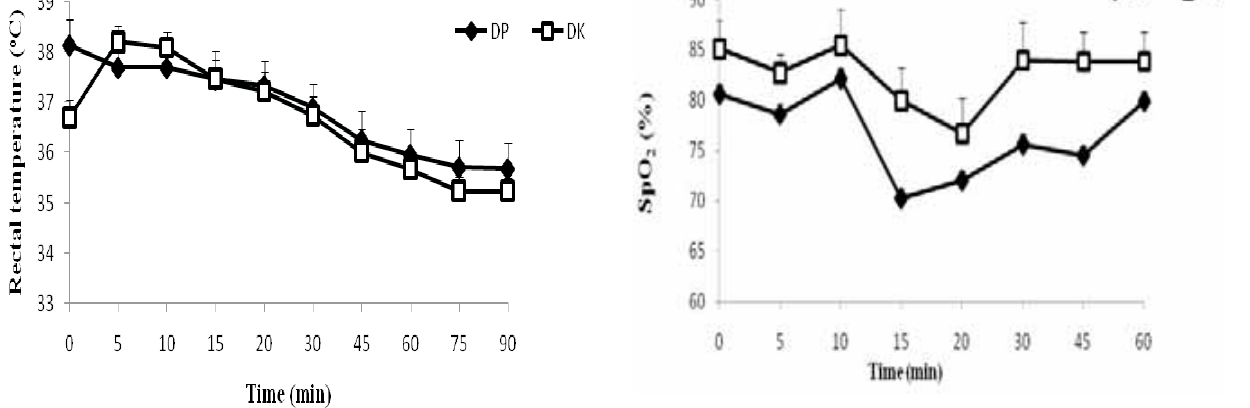
Figure-8: Mean±SE values of oxygen saturation of haemoglobin (SpO ) in the animals of groups DP and DK at 2 different time intervals.